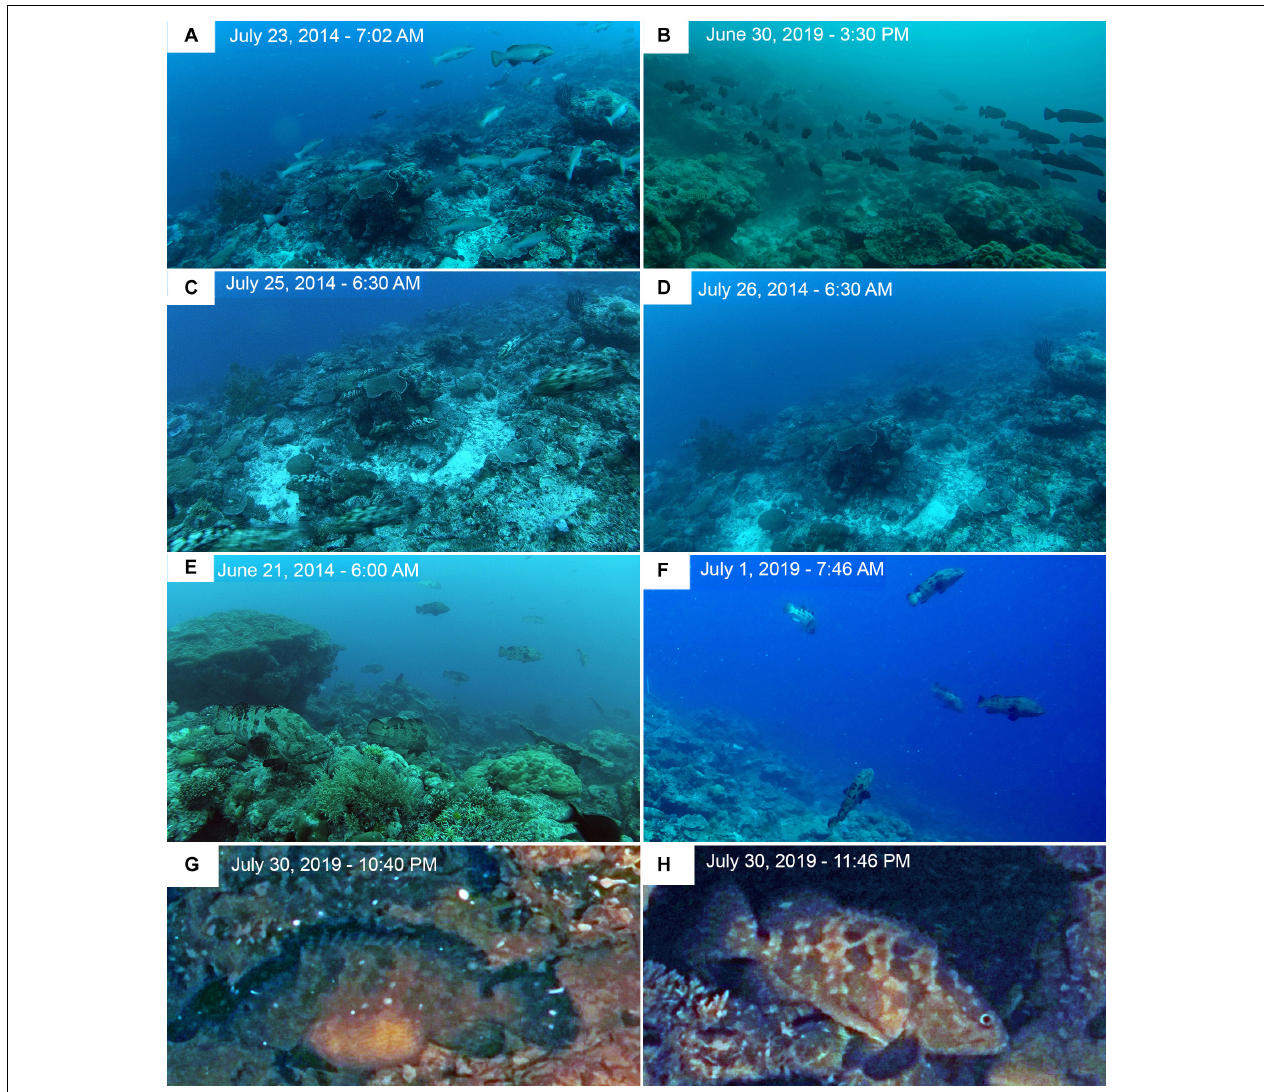
FIGURE 11 | Time-lapse images at Ebiil Channel in 2014 and 2019. (A) P. areolatus – Adults moving across site a day or two before peak numbers. (B) P. areolatus – School of small dark fish moving across site on day of peak count for the species. (C) E. polyphekadion – At first light, fish streaming out of the site; peak day had been on July 22, 3 days earlier. (D) Same location day on following morning. (E) E. fuscoguttatus – Fish up in water column where they spend a large proportion of the day, chasing, and changing colors. Some individuals remain stationed high above the substrate for extended periods as new moon approached. Numbers built to peak abundance on June 24 but fish were active, including above substrate for several days before hand, such as indicated in the image. (F) E. fuscoguttatus – Image taken on day of peak abundance for this species in June 2019. Multiple fish moved quickly between substrate and water column to form small interactive groupings. Note white survey stake in mid-left background at edge of image. (G) Night image (color corrected from red light) of a gravid female E. polyphekadion with extremely swollen abdomen (for more information on G,H ; see Supplementary Material ). (H) Image of a female E. polyphekadion , presumably the same fish, in the same location, 1 h later with a deflated